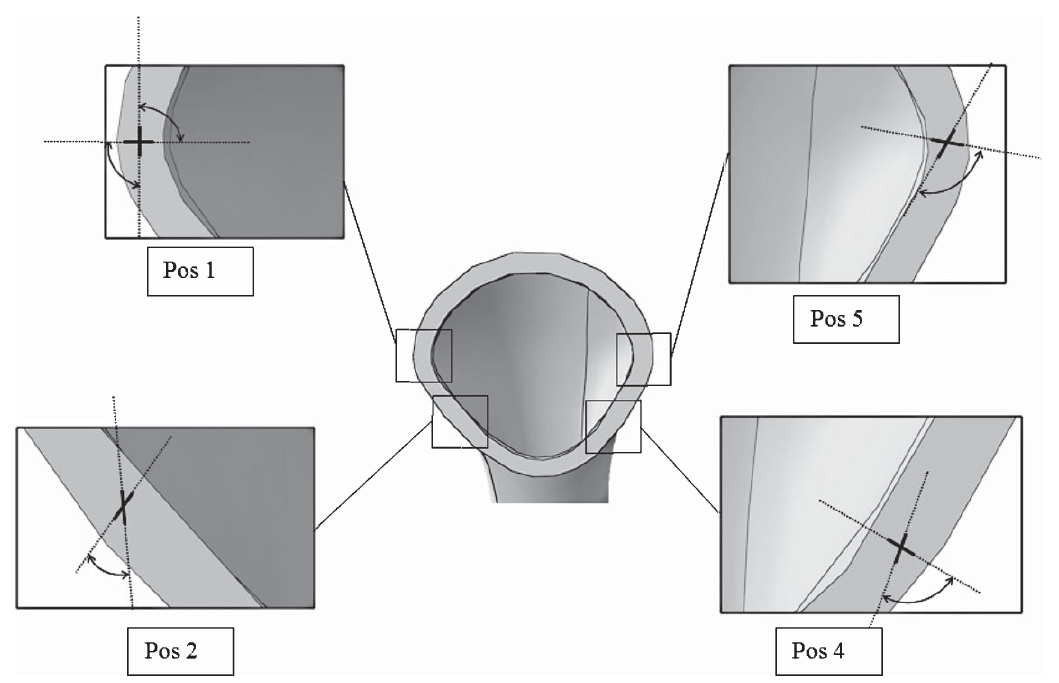
Fig. 21. Figure showing the most crack (mode II and III) critical orientations (two) in the crack opening range (K I >